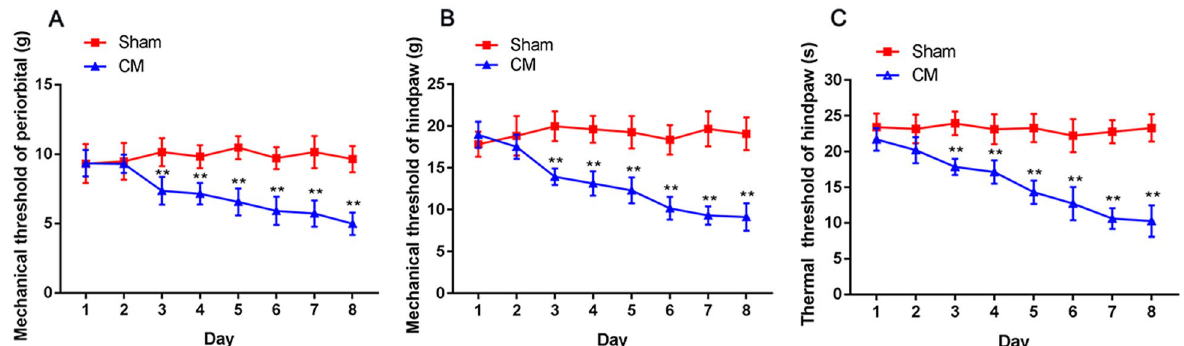
Fig. 2 The influence of repeated dural IS stimulation on hyperalgesia in CM rats. A and B Compared with the Sham group treated with PBS infusion, the mechanical pain thresholds of the periorbital region and hindpaw in the CM group treated with IS infusion markedly reduced after the second day. ( n 10/group, ** p < 0.01, vs Sham). C The thermal pain thresholds of the hindpaw in the CM group were visibly lower than those in the Sham = group after the second day. (